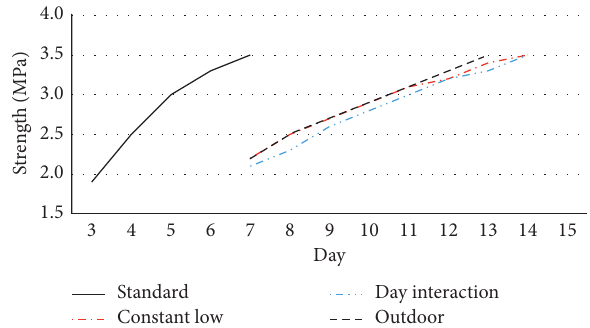
Figure 11: Comparison of strength gain law in four